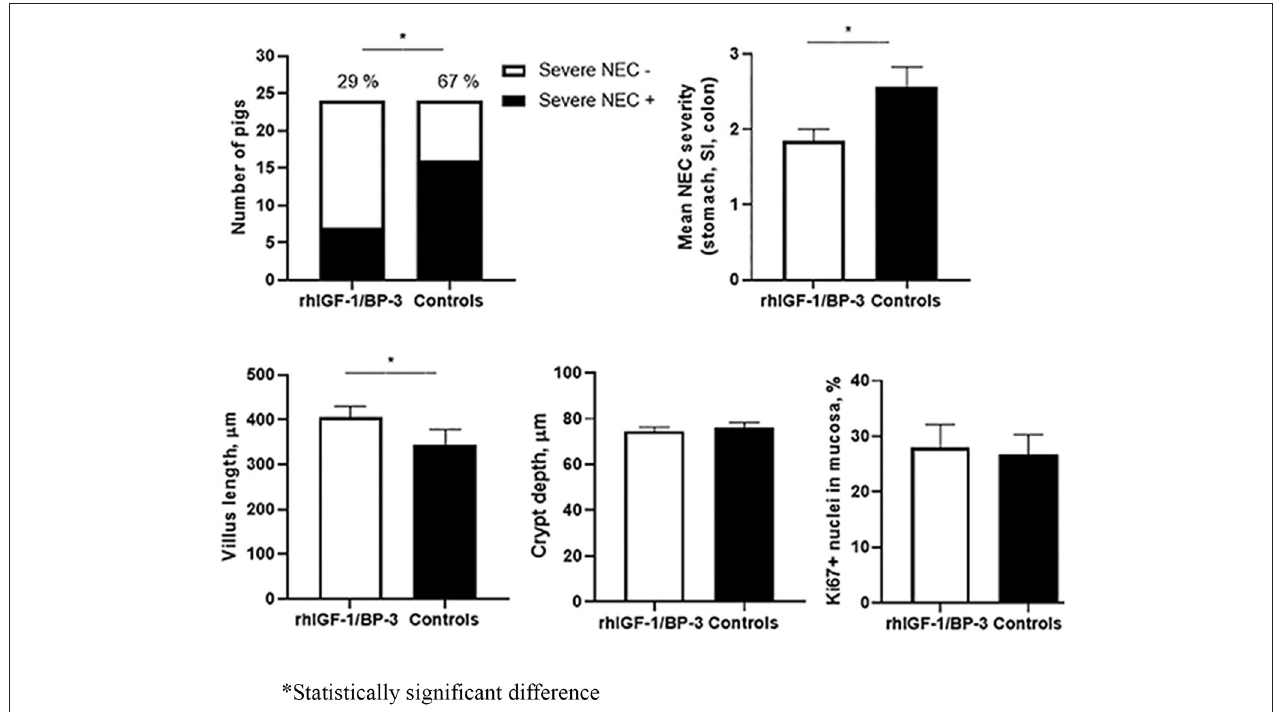
FIGURE 1 | Supplemental insulin-like growth factor-1 and necrotizing enterocolitis in preterm pigs; Holgersen et